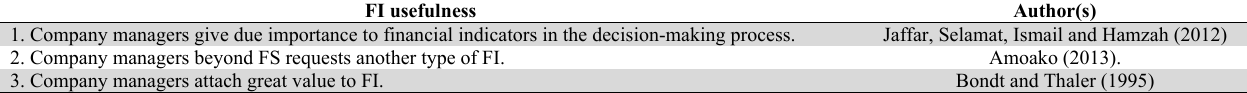
Company's Performance